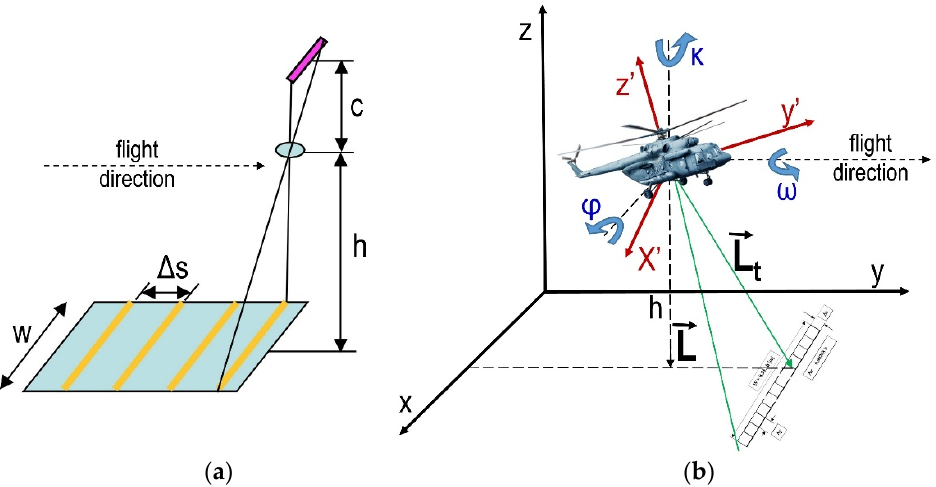
Figure 5. ( a ) Geometry of transference of the ImSpector V9 and PixelFly hyperspectral visible, near infrared (VNIR) systems, ( b ) transformation of theoretical view vector L ⃑ to effective view vector L infrared (VNIR) systems, ( b ) transformation of theoretical view vector ⃑ t. κ , ω and φ denote roll, pitch and true heading angles respectively. ω and ϕ denote roll, pitch and true heading angles